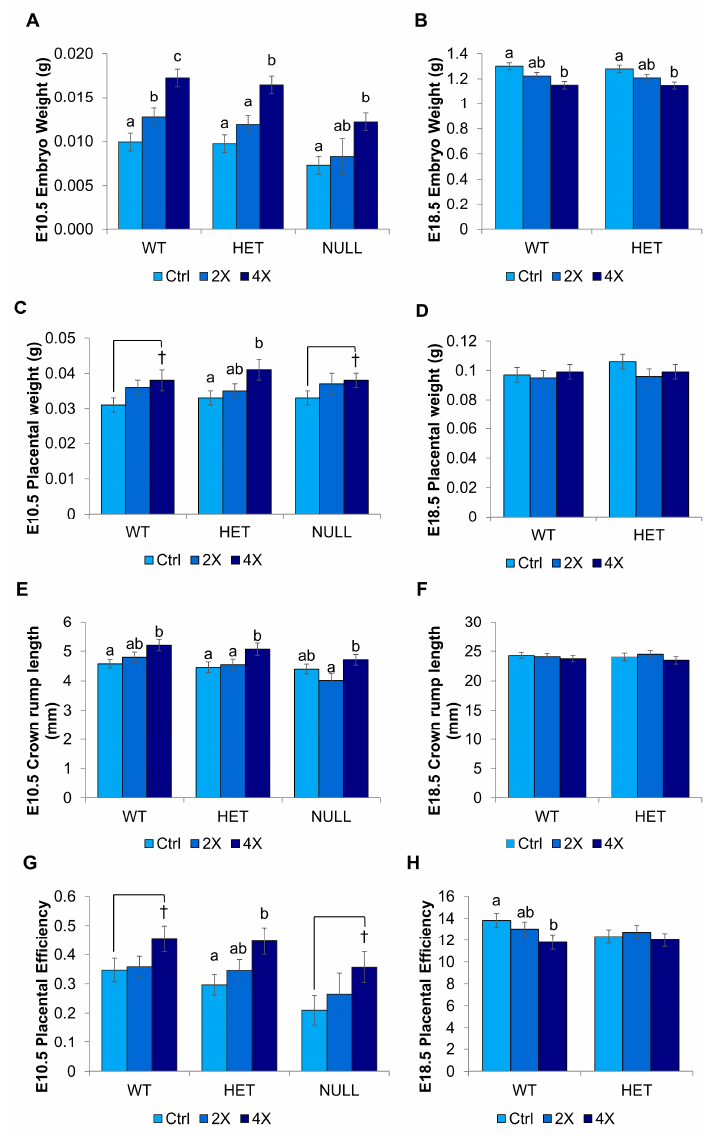
Figure 1. Fetal and placental growth characteristics by choline treatment (1X control, 2X, and 4X) and Dlx3 genotype. Embryo weight at ( A ) E10.5, and ( B ) E18.5. Placental weight at ( C ) E10.5, and ( D ) E18.5. Crown-rump length at ( E ) E10.5 and ( F ) E18.5. Placental efficiency (defined as embryo weight/placental weight) at ( G ) E10.5 and ( H ) E18.5. Data were analyzed using mixed linear models controlling for maternal identifier, fetal sex, and litter size. Values are presented as mean ± SEM. Differing letters denote p ≤ 0.05. † denotes p < 0.10. n = seven to 10 dams per treatment per time point.